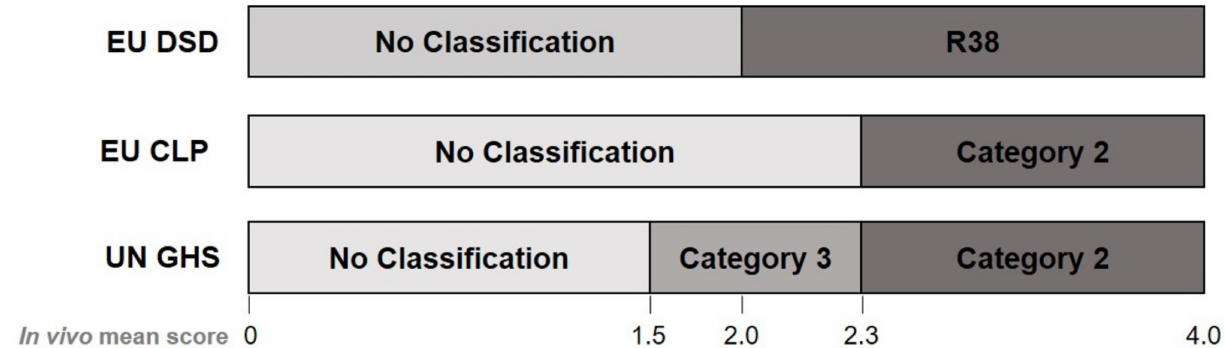
Figure 1. Erythema/edema in vivo Draize scores and classification of irritancy of EU DSD, EU CLP, and UN GHS. Erythema/edema Draize score ranges defining EU DSD, EU CLP, and UN GHS classification for skin irritation